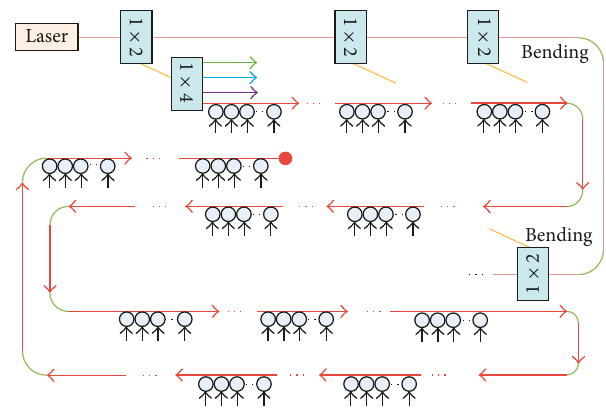
Figure 1: The layout of waveguides in Graphein.